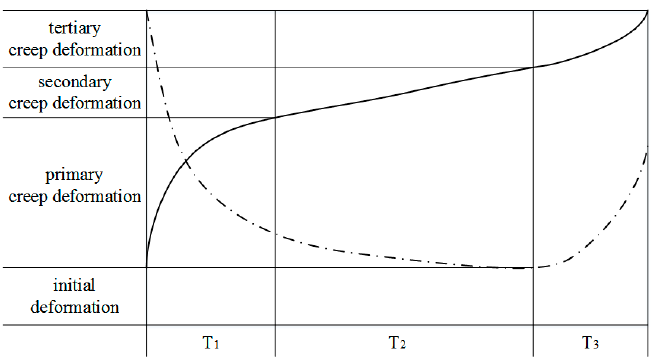
Figure 3. Typical creep strain and strain rate behavior with time. The solid line represents the creep strain, and the dashed line the creep strain rate